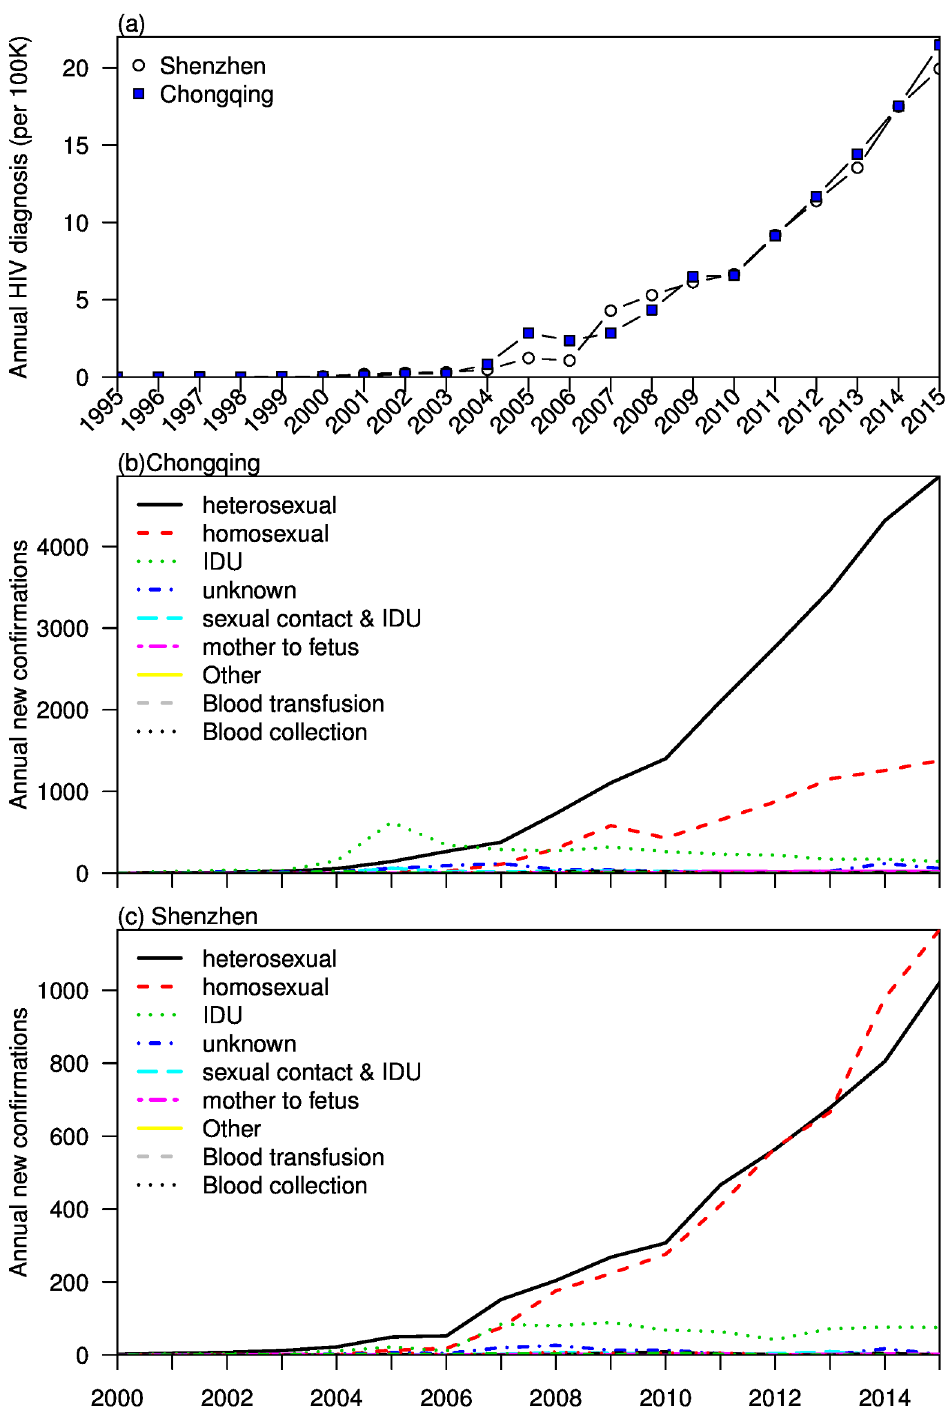
Fig 1. Comparison of HIV diagnosis in Chongqing and Shenzhen. (a) Annual totals after direct population standardization. (b,c) Annual confirmations by different routes of transmission.